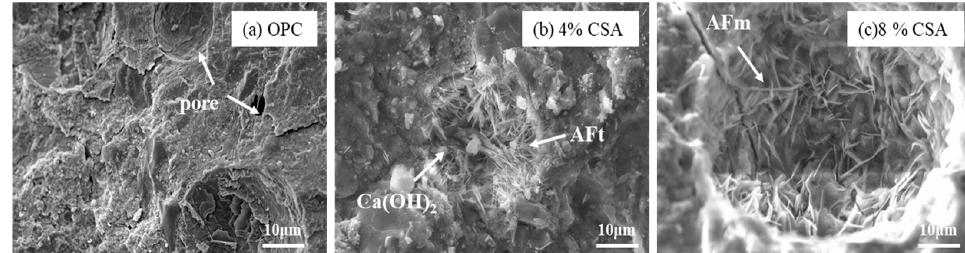
Figure 9. SEM images of OPC and OPC/CSA cement blends at 28 days, ( a ) OPC; ( b ) 4%CSA cement; ( c ) 8%CSA cement.